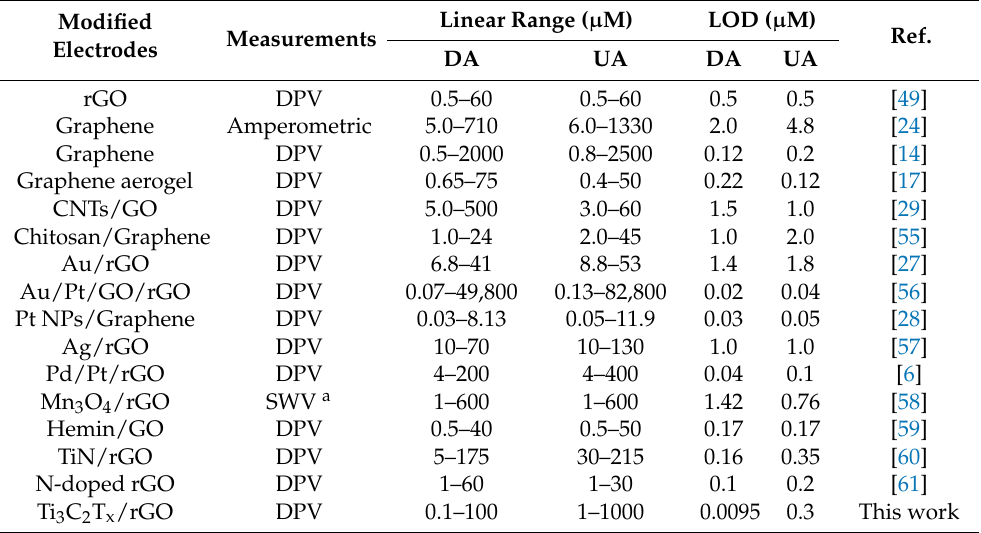
Table 1. Performance comparison of graphene-based materials modified electrodes for simultaneous detection of DA and